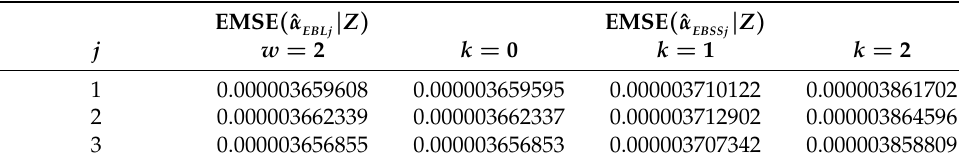
Table 17. Results of calculated EMSE for ˆ α using s = 10, u = 3, v = 4.